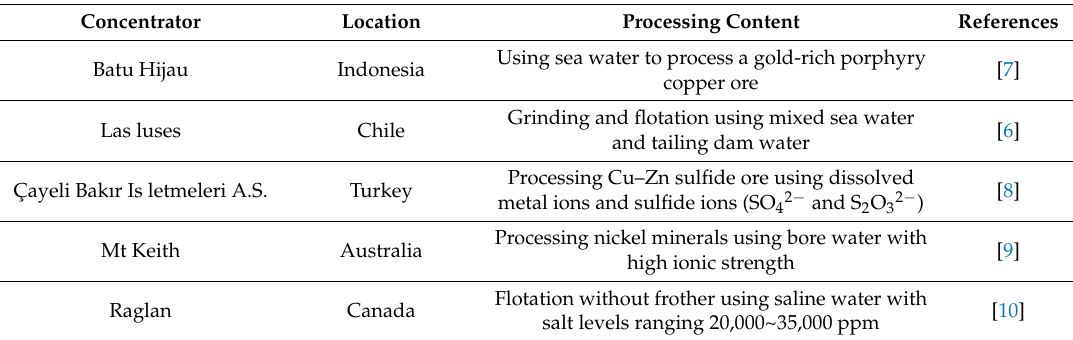
Table 1. Typical flotation practices using saline or sea